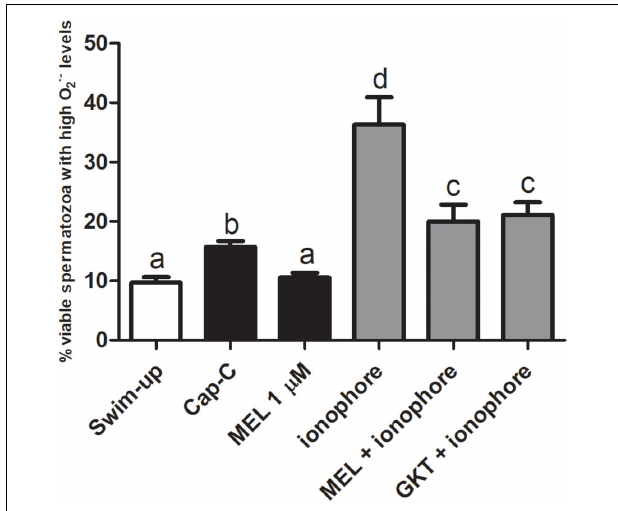
that had increased during incubation in capacitating conditions.